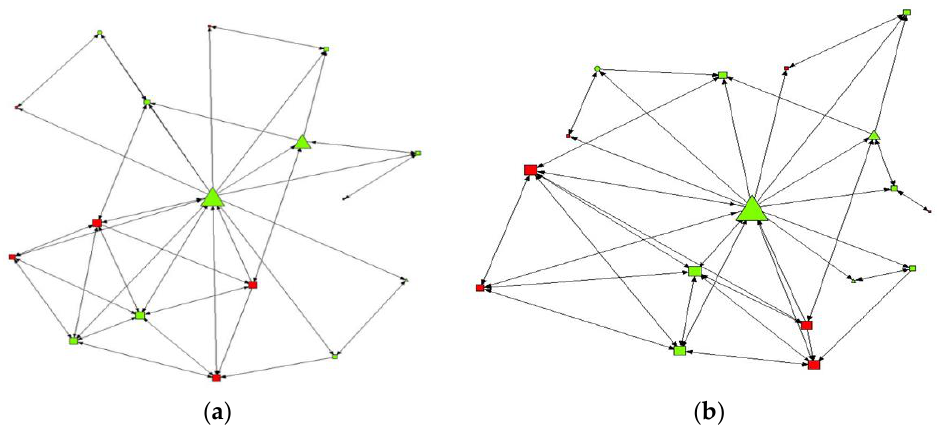
Figure 1. Structure of the friendship network and the study variables (i) Alcohol consumption and (ii) Self-efficacy. ( a ) Intermediate contact intensity by degree of betweenness, ( b ) Intermediate contact intensity by degree of closeness.